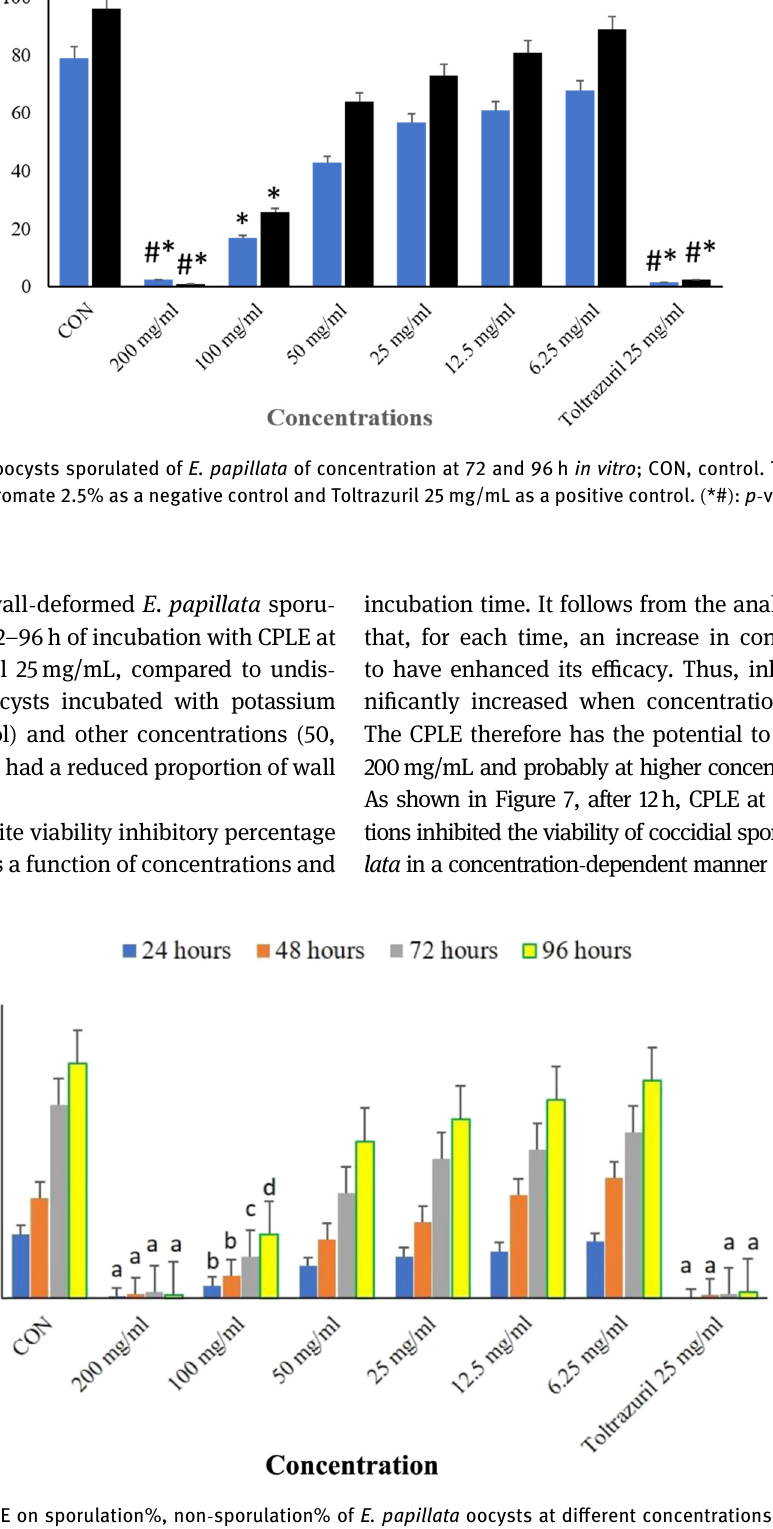
Figure 4: Main e ff ects of CPLE on sporulation%, non - sporulation% of E. papillata oocysts at di ff erent concentrations of contact time and treatment e ff ects at 24, 48, 72, and 96 h in vitro . The signi fi cance was compared to potassium dichromate 2.5% as a negative control and Toltrazuril 25 mg/mL as a positive control ( a, b, c, and d ) . Signi fi cance in comparison to the control group ( p < 0.05 )